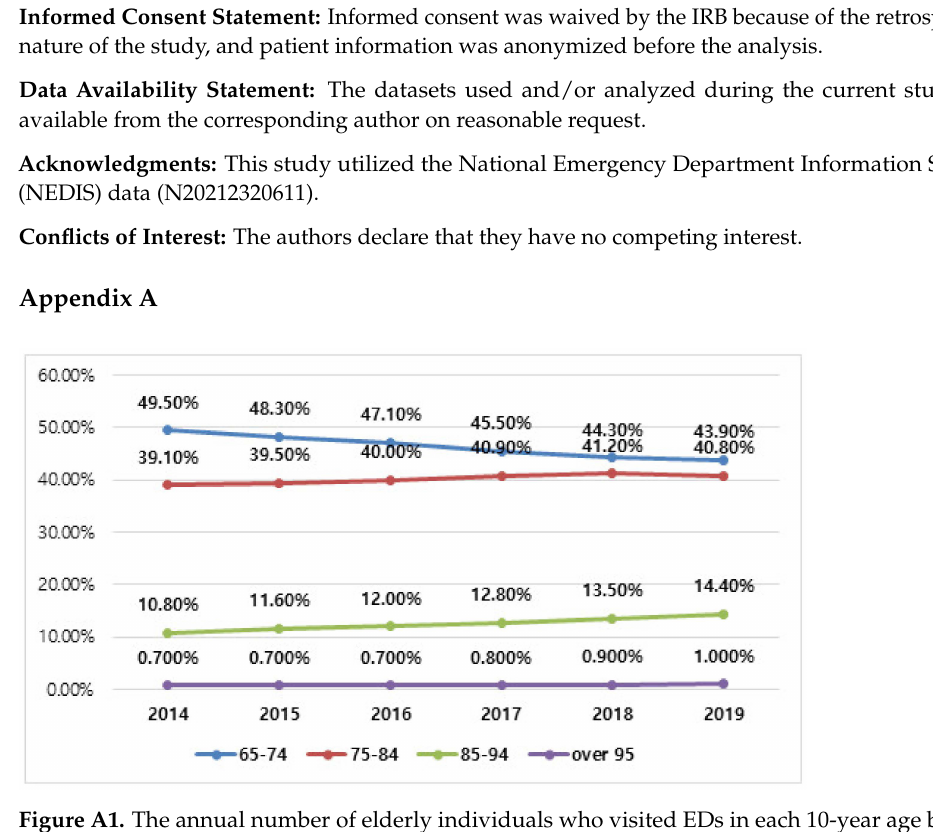
Figure A1. The annual number of elderly individuals who visited EDs in each 10-year age bracket from 2014~2019.